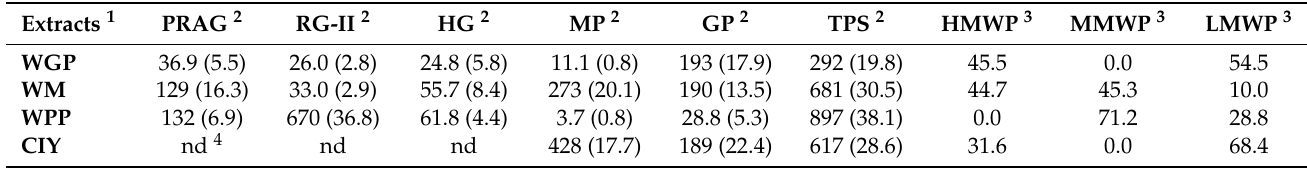
Table 1. Polysaccharide concentration (mg polysaccharide/g of extract) of the extracts determined with GC-MS and standard deviation in parenthesis and molecular weight distribution (%) determined with HPSEC-RID.